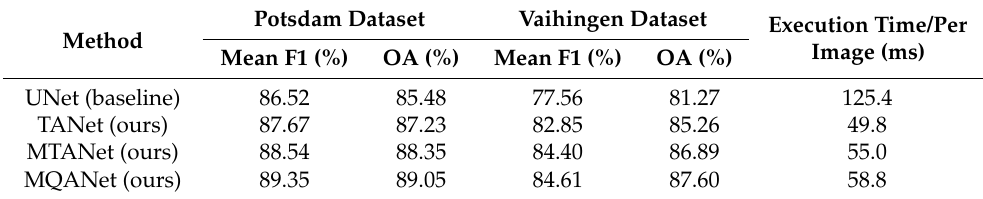
Table 8. Quantitative results of our methods. Potsdam Method